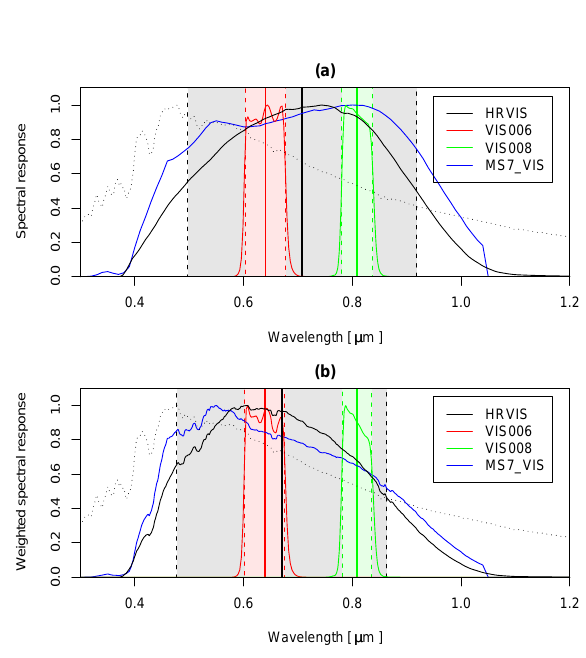
Fig. 1. Spectral response functions of the Meteosat-9 SEVIRI ra- diometer for the 0.6µm (red), 0.8µm (green) and HRV channel (black) (EUMETSAT, 2006b). The central wavelength of each channel is marked by a thick colored line, and the spectral region covered by the channel width has been shaded. The response of the Meteosat-7 MVIRI solar channel is also included for compari- son (blue). The normalized spectral response functions are plotted in (a) , while the spectral response functions weighted by the solar spectrum of Gueymard (2004) are displayed in (b) . The solar spec- trum is added as dotted line to both